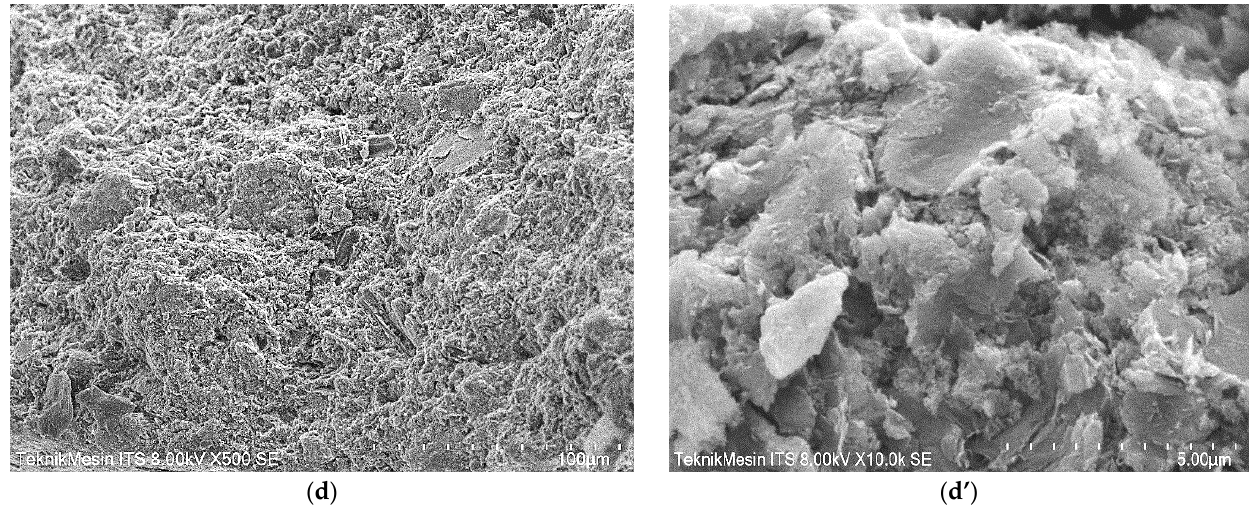
Figure 11. SEM images of the cross-sections at two different magnifications, 500 and 8000× for each sample: ( a , a’ ) Geopolymer; ( b , b’ ) Geo–TiO 2 (3); ( c , c’ ) Geo–rGO–TiO 2 (0.5, 3); ( d , d’ ) Geo–rGO–TiO 2 (1, 3). Table 4. Atomic ratios of Si:Al and Na:Al at the samples cross-sections, in at.%. Sample